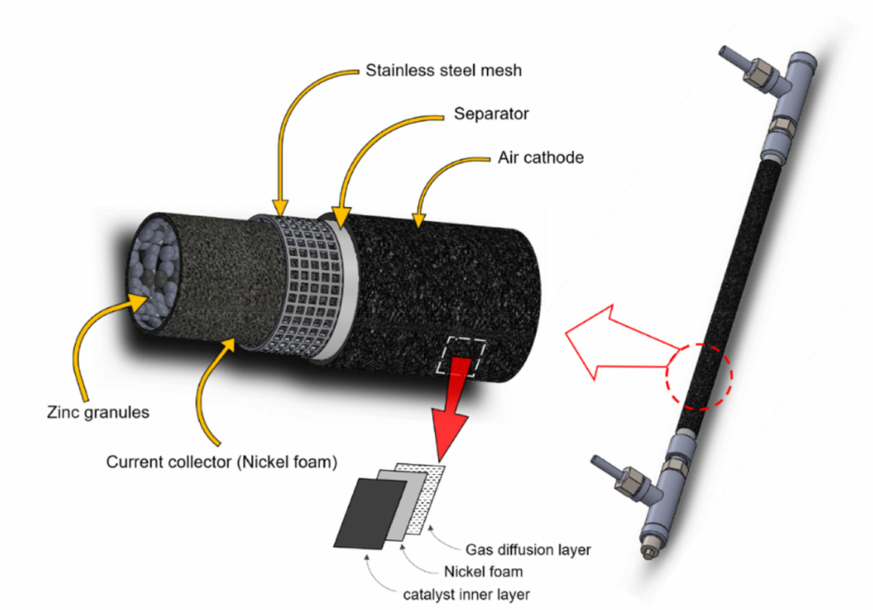
Figure 6. Schematic view of the Zn–air flow battery and its components.